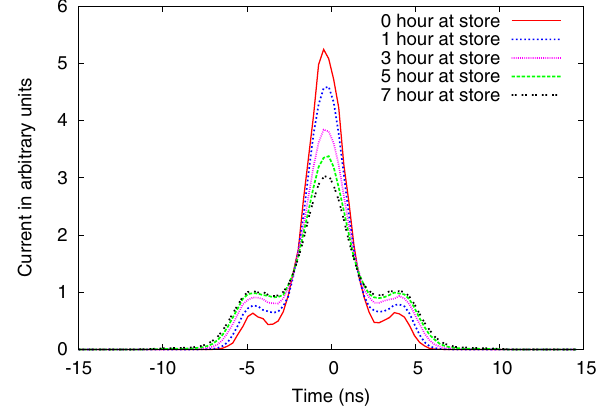
FIG. 16. Longitudinal bunch profiles at store from multiparticle simulation with 300 kV 197 MHz rf cavities. Momentum aperture is not included.